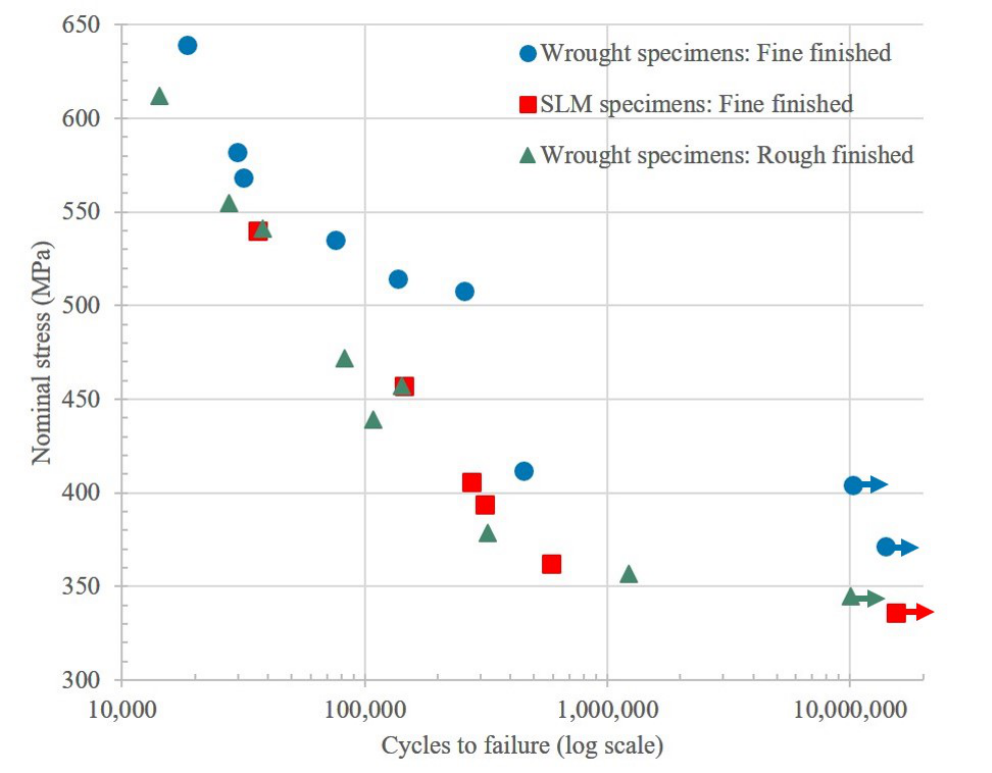
Figure 17. Wohler curve plot of wrought and SLM fabricated